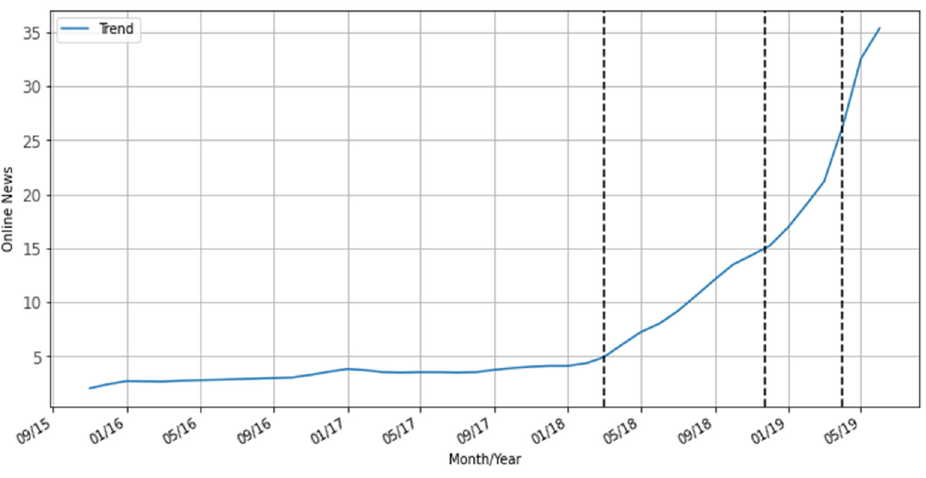
Figure 4. Trend graph of online news stories on syphilis in Brazil between